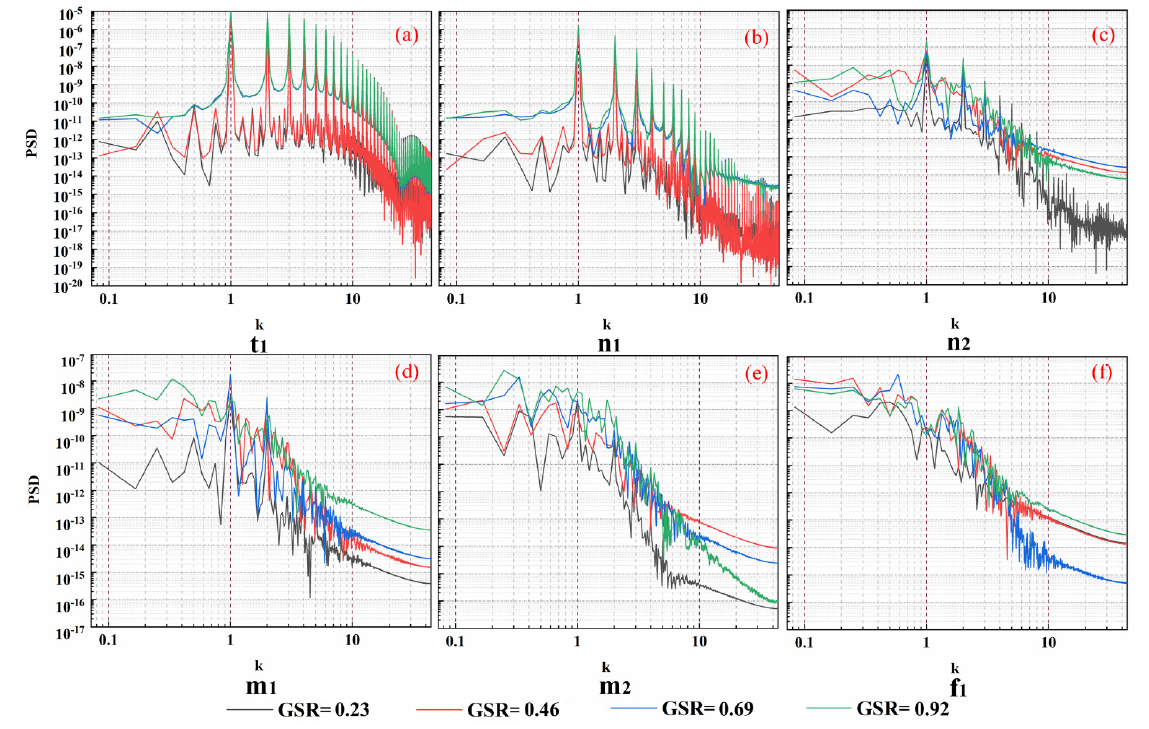
Figure 19. Enlarged diagram of PSD at measuring points. ( a ) The PSD distribution at t 1 measuring point; ( b ) The PSD distribution at n 1 measuring point; ( c ) The PSD distribution at n 2 measuring point; ( d ) The PSD distribution at m 1 measuring point; ( e ) The PSD distribution at m 2 measuring point; ( f ) The PSD distribution at f 1 measuring point.